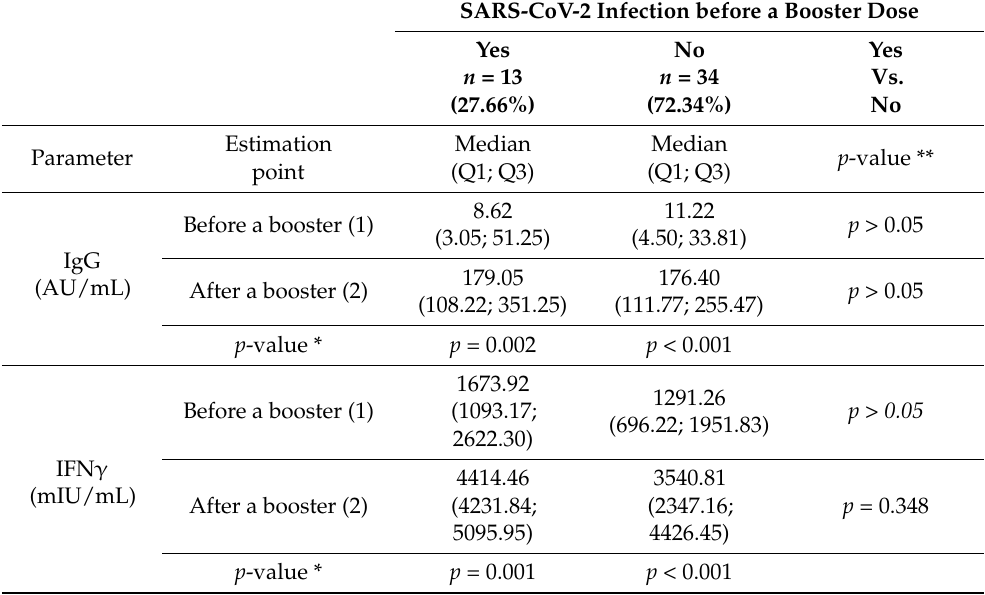
Table 3. Changes in the concentration of IgG antibodies and interferon-gamma concentration levels in the study group ( n = 47) depended on SARS-CoV-2 infection in anamnesis before and after receiving a BNT booster. Results of multiple comparisons (post hoc tests).